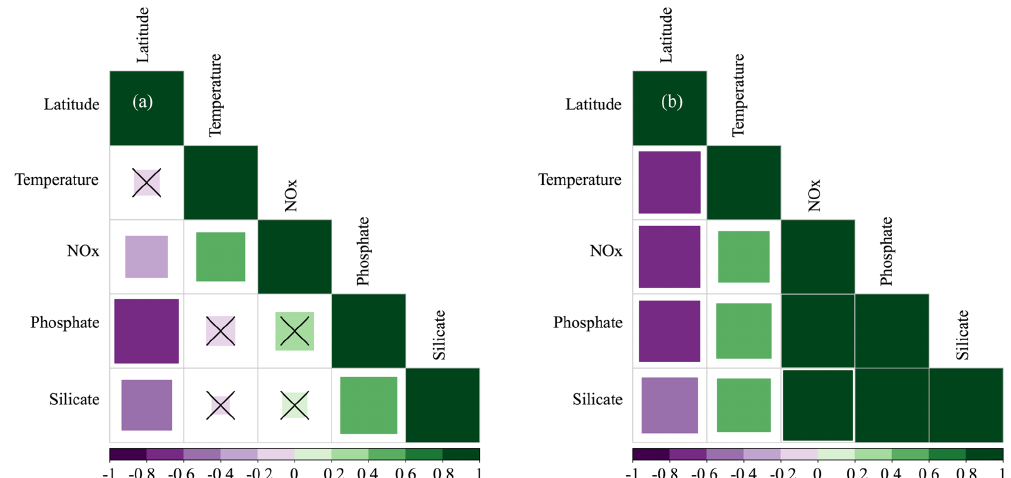
Figure 3. Pearson correlations between environmental variables (temperature and the concentrations of nitrate + nitrite [NO x ], phosphate, and silicate) and their latitudinal distribution measured at selected depths: (a) the first optical depth (from the surface down to 37% of incident PAR) and (b) at the bottom of the photic layer (between 1% and 0.1% of incident PAR values). The size of the squares is the magnitude, and the colour indicates the direction (green for positive correlations and purple for negative correlations). The value of the correlation coefficient ( r ) is shown in the colour bar below the graphs. Non-significant correlations are denoted with a “ ×